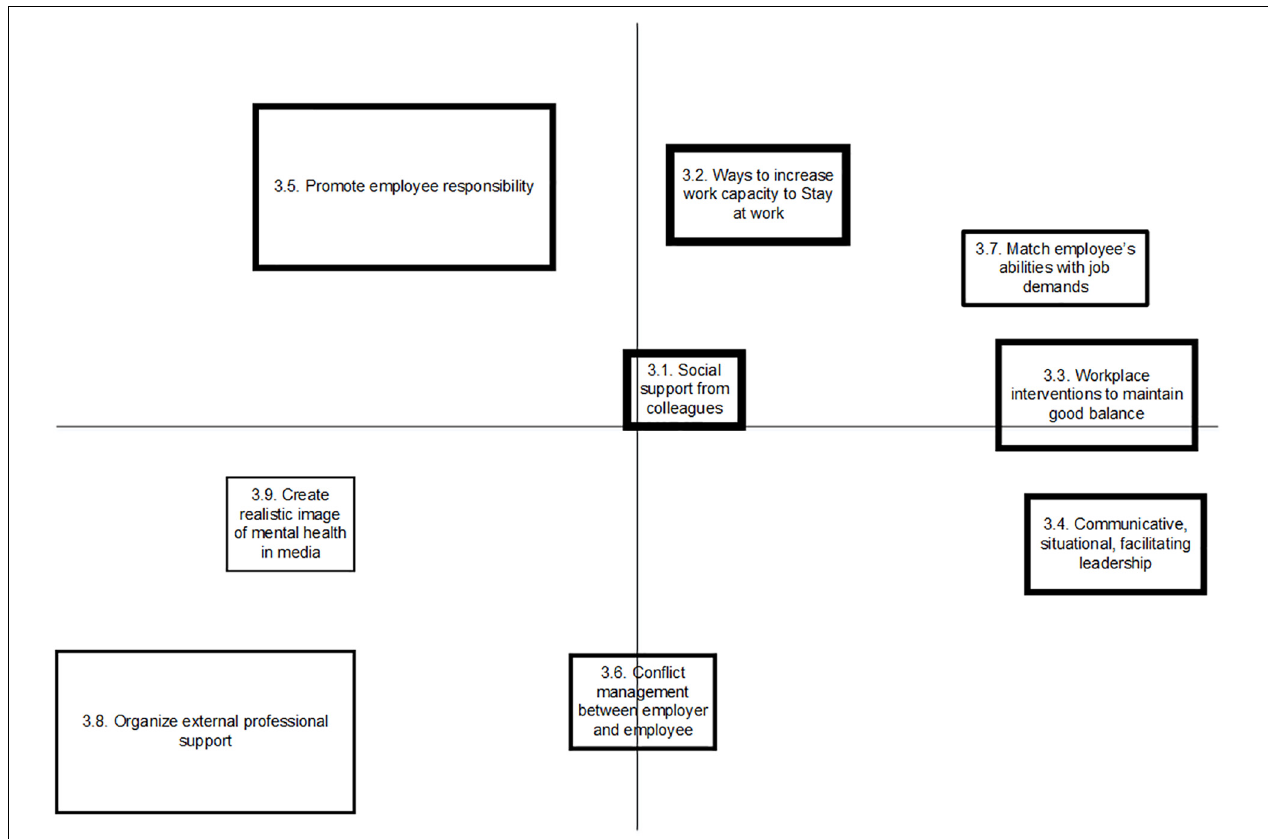
FIGURE 3 | Concept map on factors promoting Stay at work, representing the perspective of occupational health professionals